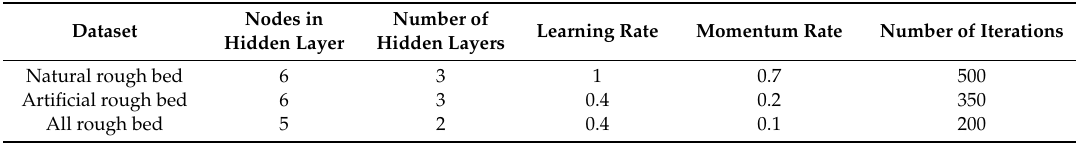
Table 3. Details of user-defined parameters for the best topology of a neural network (NN) classifier in the datasets.